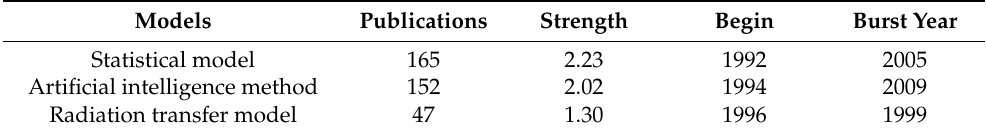
Table 7. Quantitative remote sensing modeling methods.